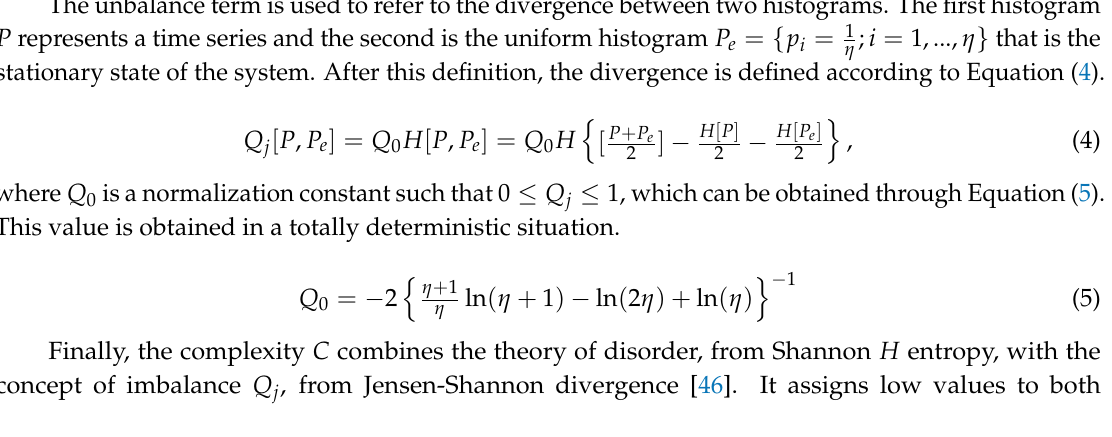
Figure 7. The distributions P and Q are different but have the same entropy value H = 0.875 (normalized entropy